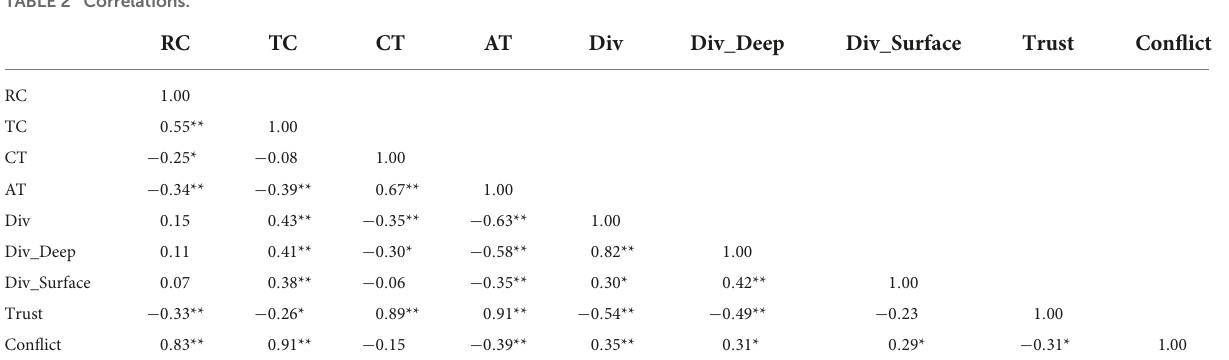
TABLE 2 Correlations.